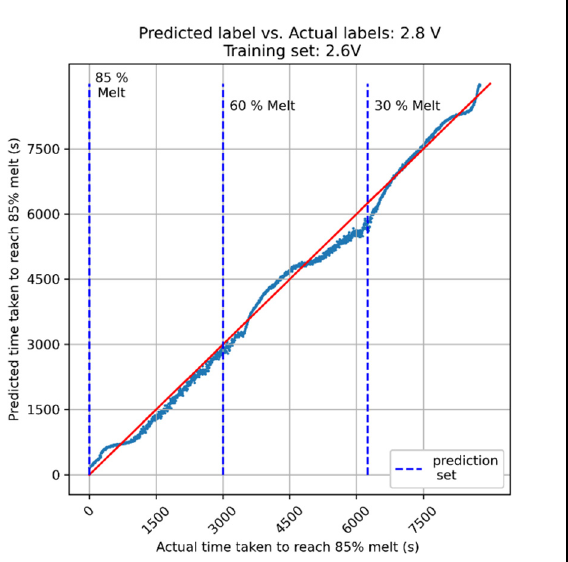
Figure 12. Scatter plot comparing the ANN predictions with experimental data for test data set of 2.8 V (training data set of 2.6